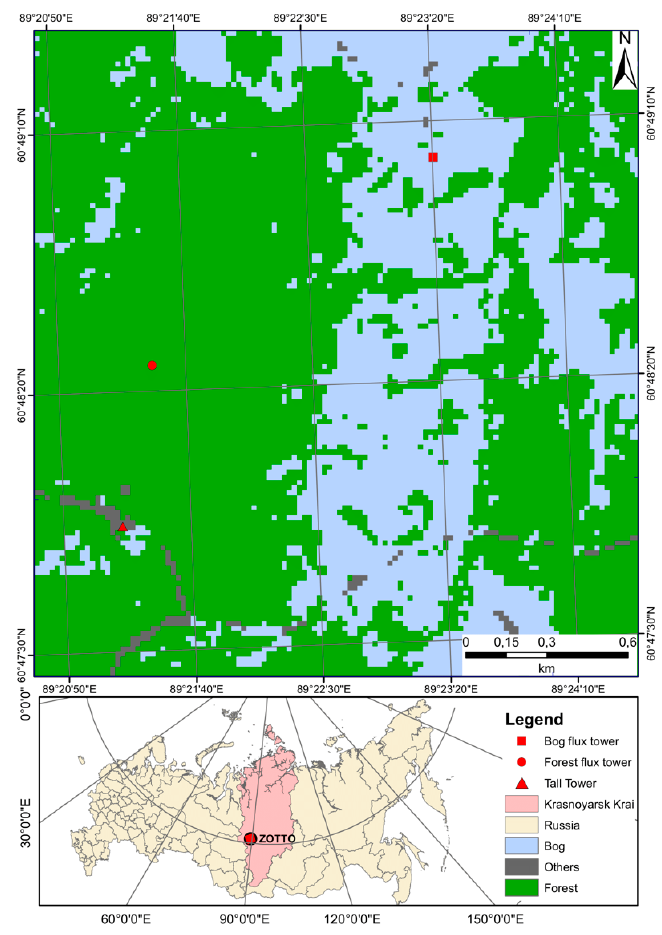
Figure 1. Land-cover map and geographical locations of forest (ZF; red circle) and bog (ZB; red rectangle) flux towers and tall tower (red triangle) in Zotino, Krasnoyarsk Krai, Russia (black circle). The map is derived from 30 m resolution Landsat-8 image. The ZOTTO denotes the Zotino Tall Tower Observatory. We reclassified 14 initial land-cover types into 3 types. Forest includes reforestation, regrowth, and lichen with pines. Bog includes shrubs, flooded, and wet body. Other classes (others) include clear-cut/barren, burned, sand, and sparse vegetation. Table 1. Site characteristics of the forest and bog flux towers at Zotino. ZF ZB Geographical location